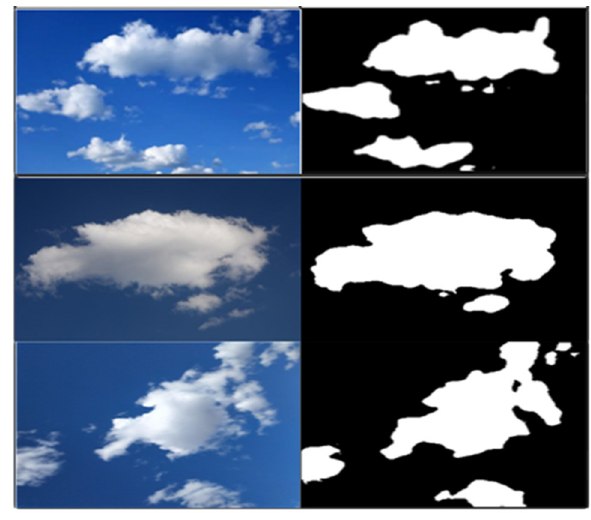
Figure 4. Example results of PSPNet.